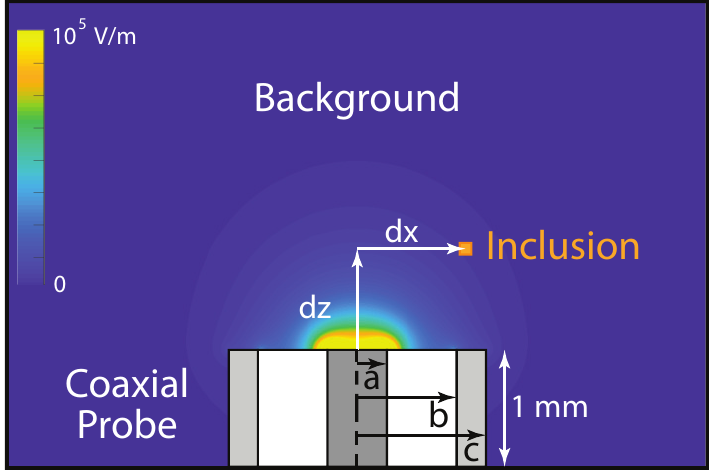
Figure 1. Experimental setup and parameters. A small, cubic inclusion with permittivity contrasting to the background was swept through x , y , and z directions around an open-ended coaxial probe. Background colormap illustrates the probe electric field magnitude assuming a 1W input power. Color scale is linear.